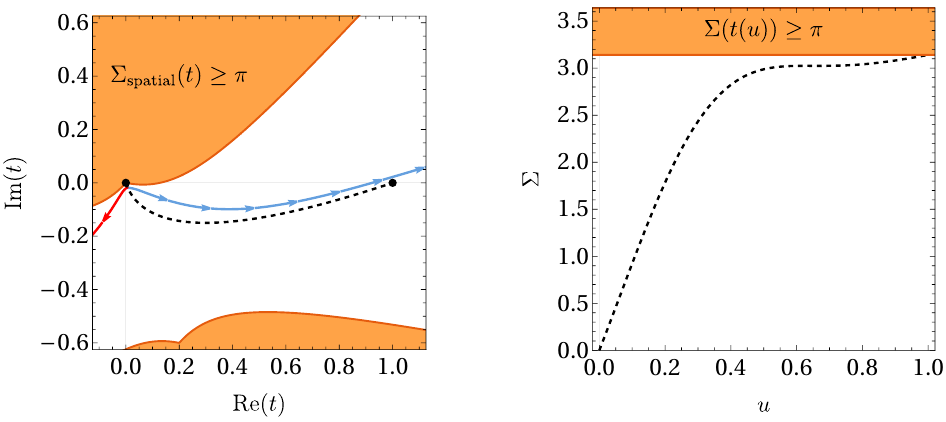
Figure 11 . Left : complexified t plane for the saddle point solutions with Neumann-Dirichlet boundary conditions. Here q 1 = 10 and Λ = ( D − 1)( D − 2) / 2 . The shaded region corresponds to non-allowed metrics according to the spatial LSKSW criterion alone, i.e., in these regions ( D − 1) | Arg( q ) | ≥ π . Black dots reside at t = 0 and t = 1 , indicating the end points of the time path specifying the metric. The blue line is the line of maximal angle and the red that of minimal angle — an allowable path must reside in between. How those lines are found is explained in section 2.3.3. We can see that the point t = 1 is reachable while staying below the blue and above the red lines, for example using the black dashed path. Right : we explicitly verify that the dashed path is indeed allowable, by plotting the full Σ along it. It everywhere stays below the limiting value π , indicated by the orange